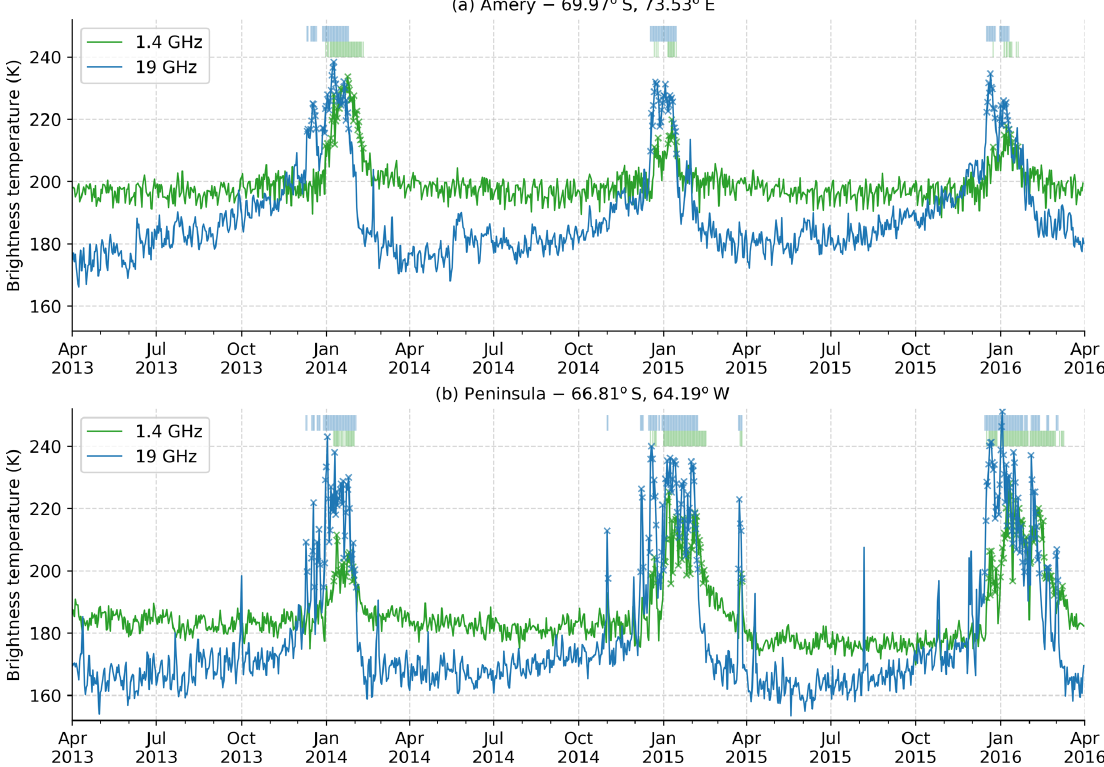
Figure 1. Brightness temperature at H polarization (K) at 1.4GHz (green) and 19GHz (blue) from April 2013 to March 2016 at (a) the Amery area and (b) the Antarctic Peninsula. The melting days detected by each frequency are depicted by crosses on the time series and recalled by pale lines above.